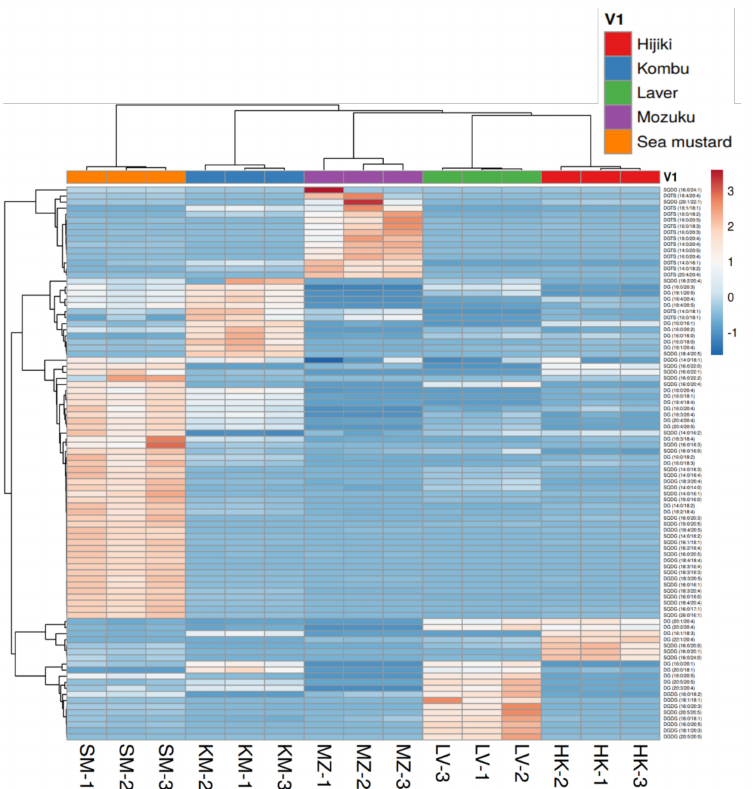
Figure 5. Hierarchical cluster correlation heatmap of glycerolipids including diacylglycerols (DG) and its derivatives, such as sulfoquinovosyl diacylglycerol (SQDG), digalactosyldiacylglycerol (DGDG), and diacylglyceryl-trimethylhomoserine (DGTS). HK: Hijiki, KM: Kombu, LV: Laver, MZ: Mozuku, SM: Sea